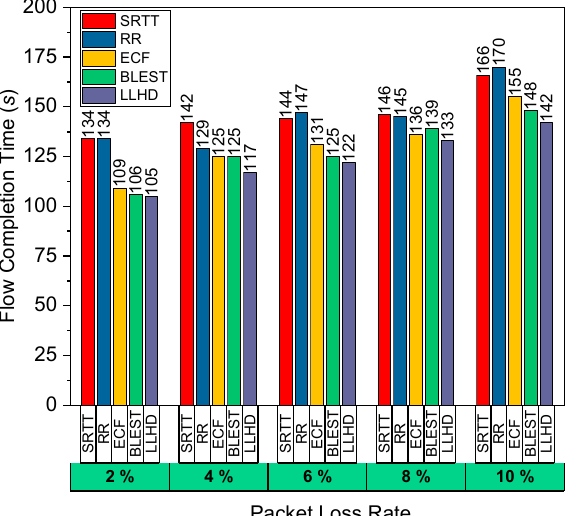
Figure 3. Performance evaluation of the considered schedulers in terms of FCT for variate packet loss rate in Scenario #2.